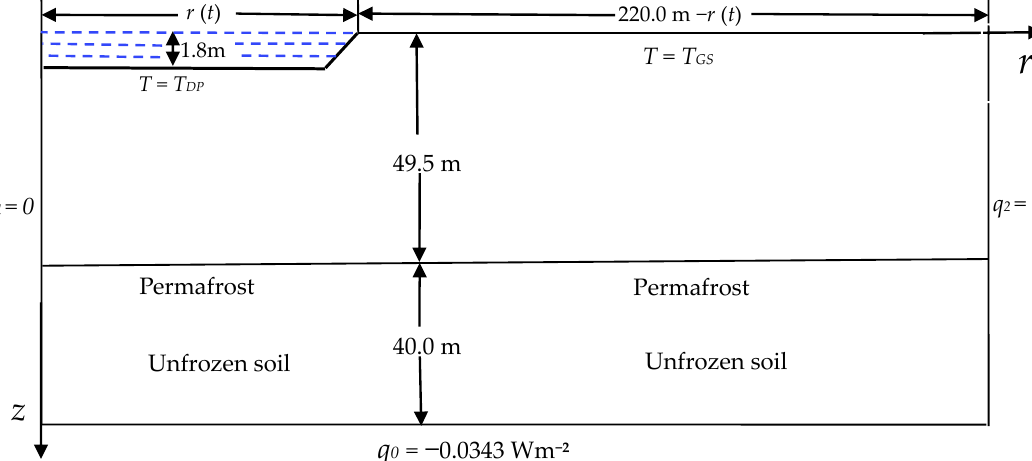
Figure 2. Diagrammatic drawing of the analysis domain. The lake radius expanded from the initial length of 6.0 m with a horizontal expansion rate of 0.25 m/year. The upper boundaries are set at a depth of 0.5 m below the lake bottom off the shore and at a depth of 0.5 m beneath the ground surface on the shore. The soil types in the analysis domain are silty clay, silt and clay, sand and gravel, and mudstone successively from the upper boundary to the lower boundary; the corresponding soil thicknesses are 2.3 m, 3.0 m, 9.7 m, and 75.0 m, respectively. Table 1. The soil types and their physical and thermal parameters used in this study.